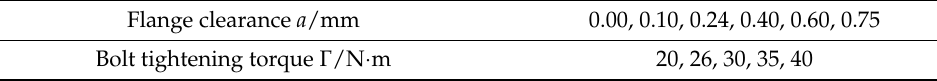
Table 1. All experimental working